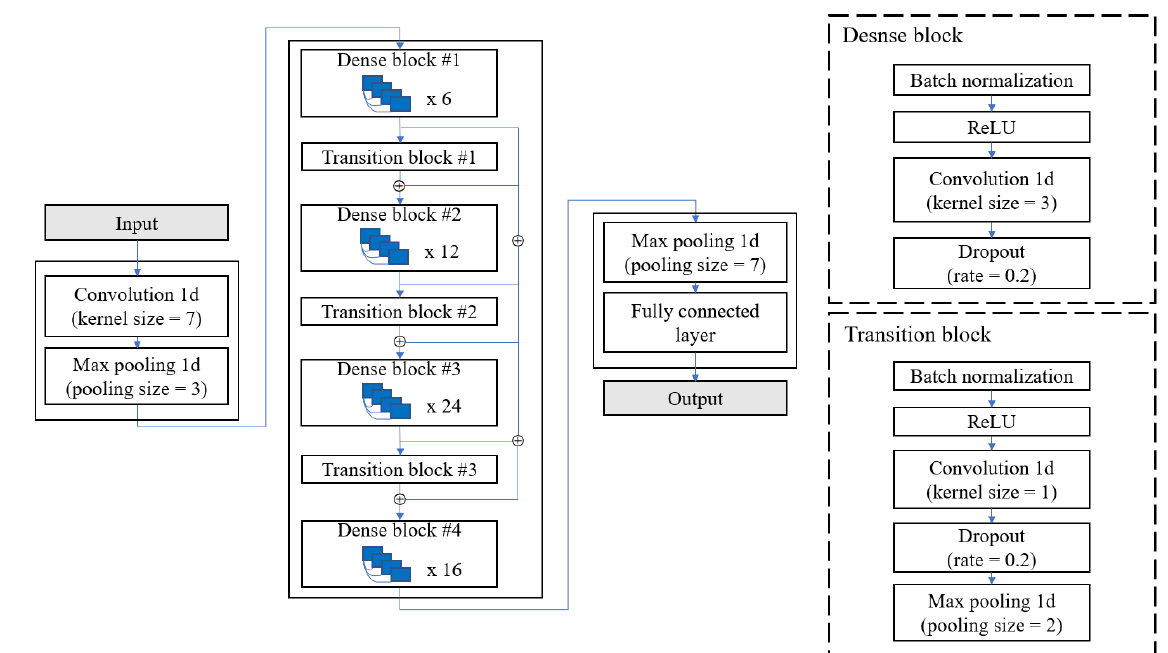
Figure 8. Internal structure of DenseNet. ⊕ denotes the concatenation of feature